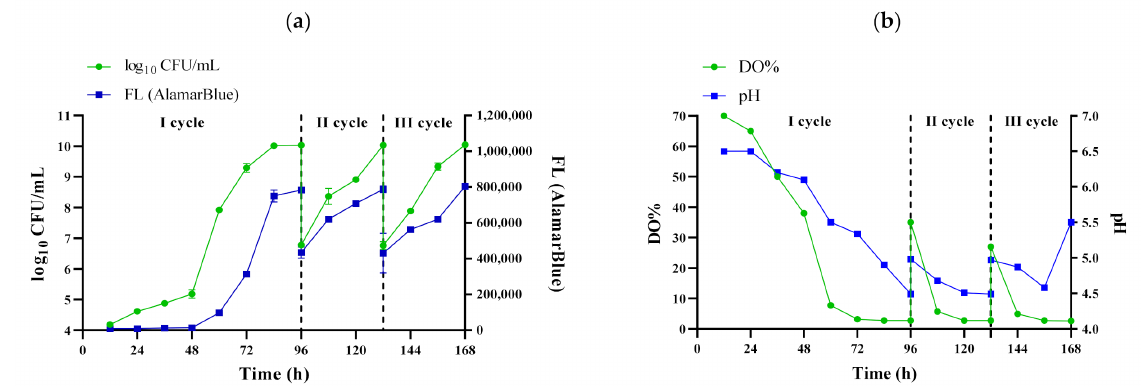
Figure 4. ( a ) The number of living cells and metabolic activity of K. xylinus based on fluorescence of AlamarBlue reagent; ( b ) pH and DO% of the culture medium during the process of inoculum preparation. Data are presented as a mean ± stan- dard error of the mean